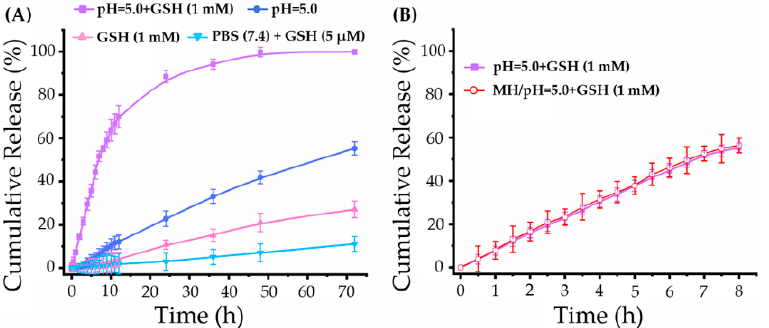
Figure 5. Drug release profiles of MTN under different conditions: ( A ) Pt release profiles of MTN under intracellular environment (pH = 5.0 + 1 mM GSH), physiological condition (pH = 7.4 + 5 μ M GSH), pure acid environment (pH = 5.0), and pure reductive environment (1 mM GSH); ( B ) the influence of MH on Pt release under intracellular environment.